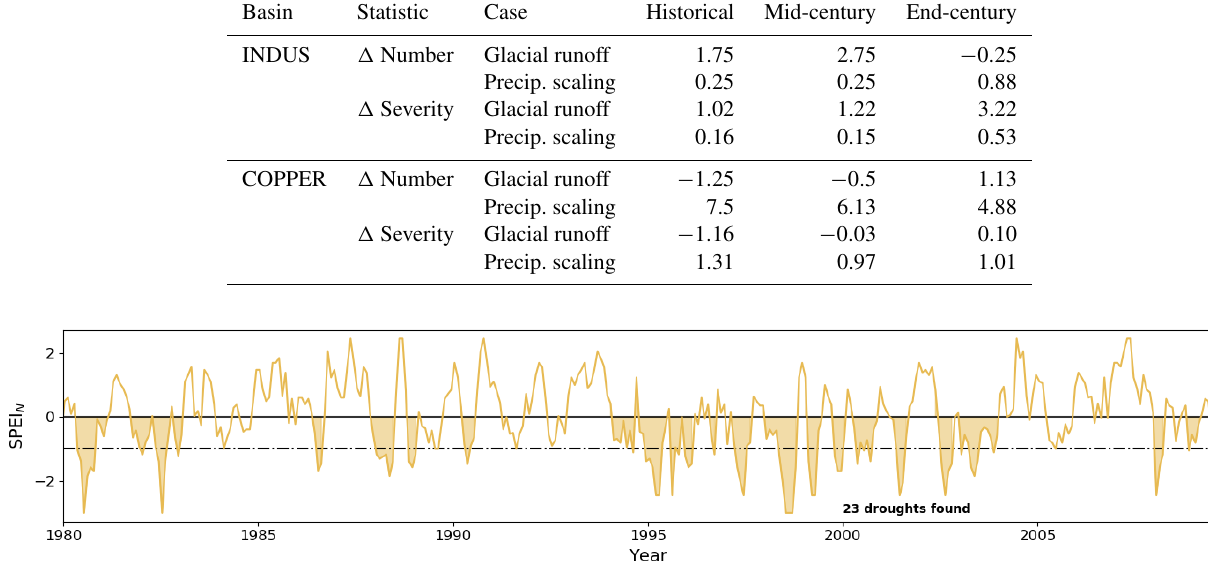
Figure B3. SPEI N time series for the Tarim basin, 1980–2010, with droughts shaded. The accumulated SPEI deficit we analyze as “severity” for each drought can be visualized here as the sum of monthly SPEI values in a continuous shaded